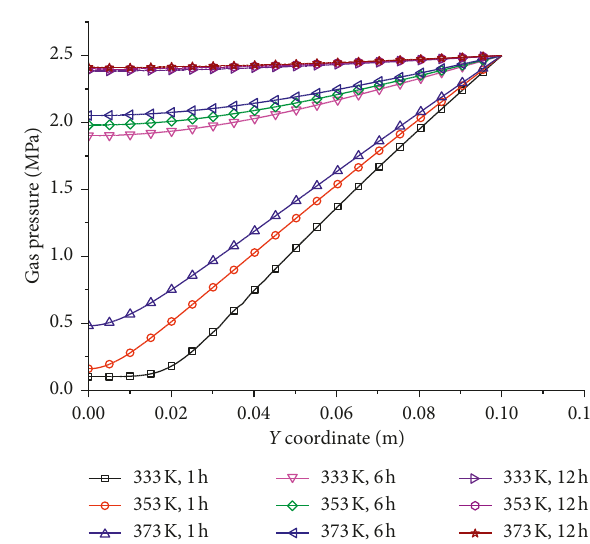
Figure 11: Gas pressure distribution with different temperatures.